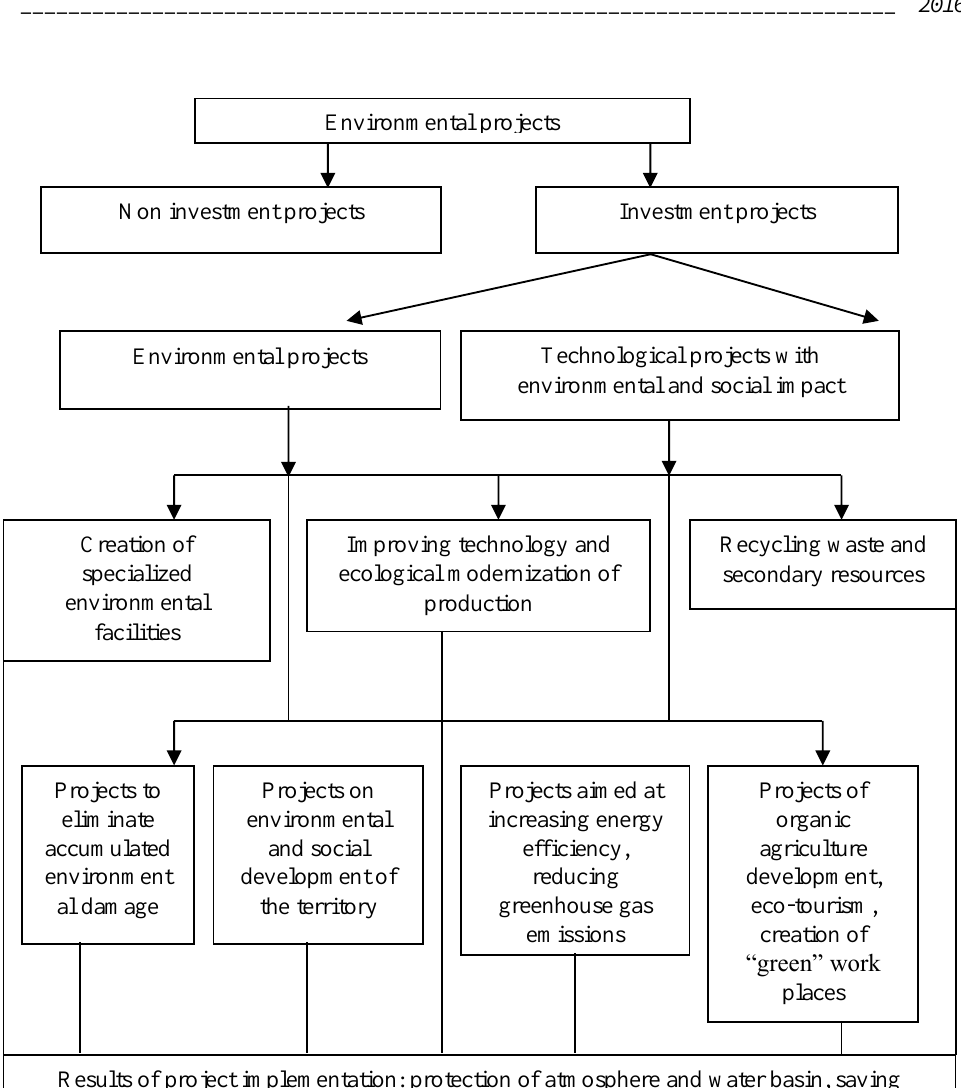
Fig. 2. Classification of environmental projects for project financing